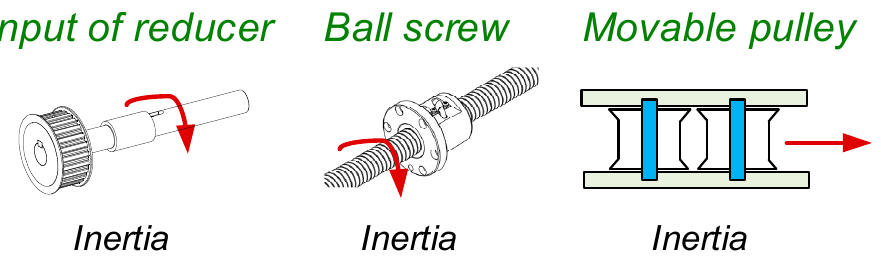
Figure 11. Inertial energy storage schematic diagram of the ETD.